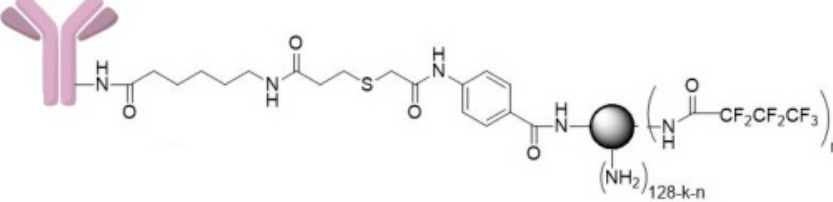
Figure 7. Thioether cross-linked dendrimer conjugate Trastuzumab derivative ( 5 ).